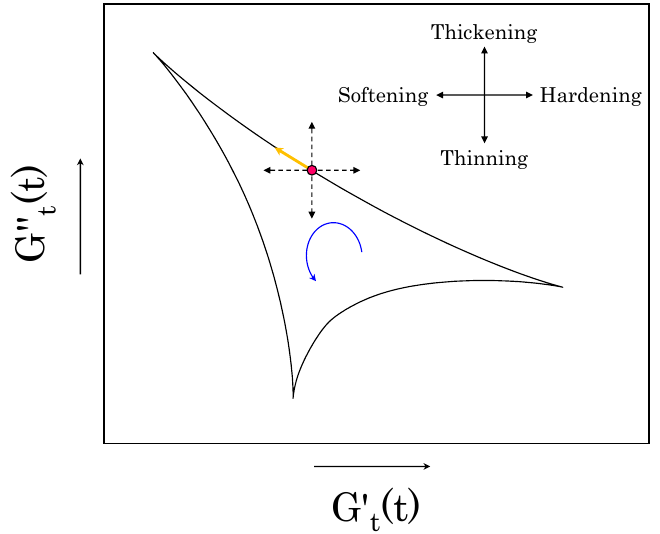
Figure 3. Schematic of the rheological transitions that can be observed using the Cole–Cole plot. As an example, we highlight the instantaneous trajectory of a point on the curve (yellow arrow). In that part of the cycle, the instantaneous storage modulus is decreasing, while the instantaneous loss modulus is increasing; this indicates a simultaneous softening and thickening of the